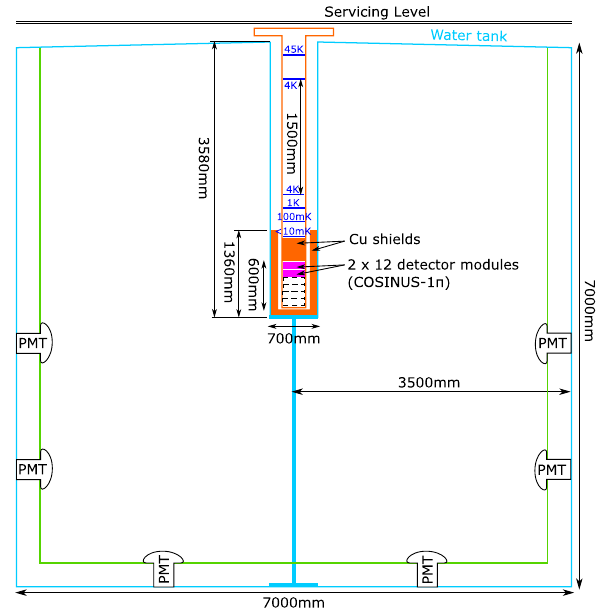
Fig. 3 Simplified scheme of the cryostat in the dry-well of the water tank.Lightblue:stainlesssteelwallsofwatertankanddry-well.Orange: copper parts (shielding and cryostat). Solid magenta, dashed black: experimental volume needed for COSINUS-1 π (corresponding to a maximum total mass of ∼ 3.6 kg of NaI) and -2 π (up to a total mass of ∼ 10.8 kg of NaI), respectively. Blue: temperature stages of the cryostat. Green: light-tight curtain made of e.g. Tyvek to create a passive layer at the water tank walls. This scheme is based on the favoured solution (Option 4) for the shielding concept as found by MC simulations (see Sect.